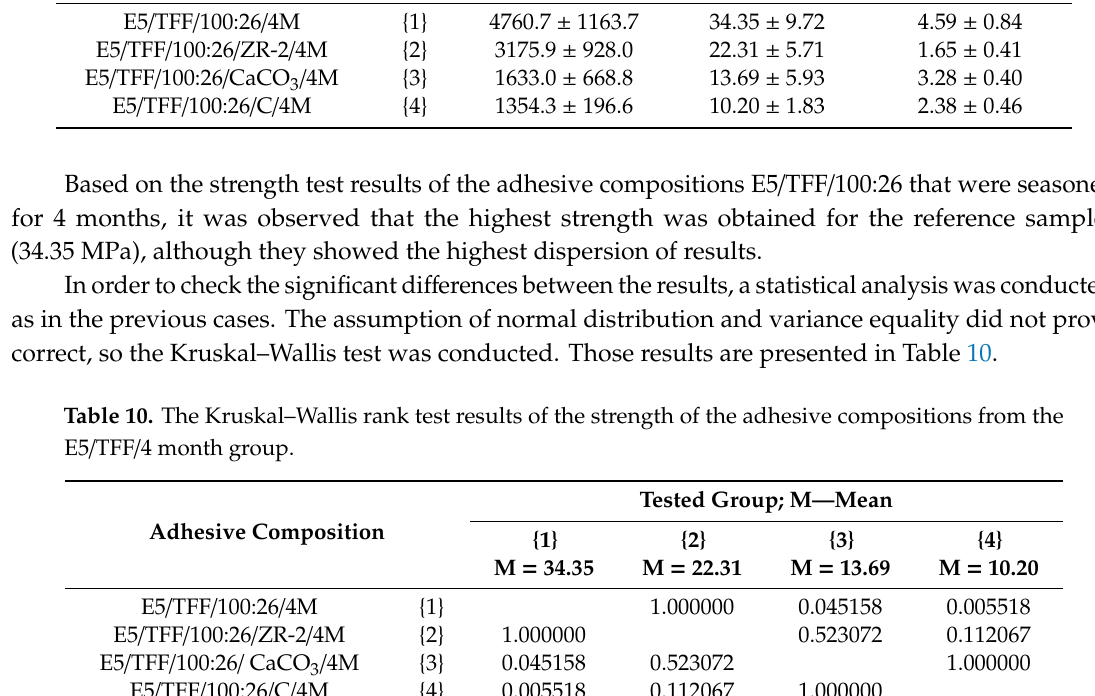
Adhesive Composition